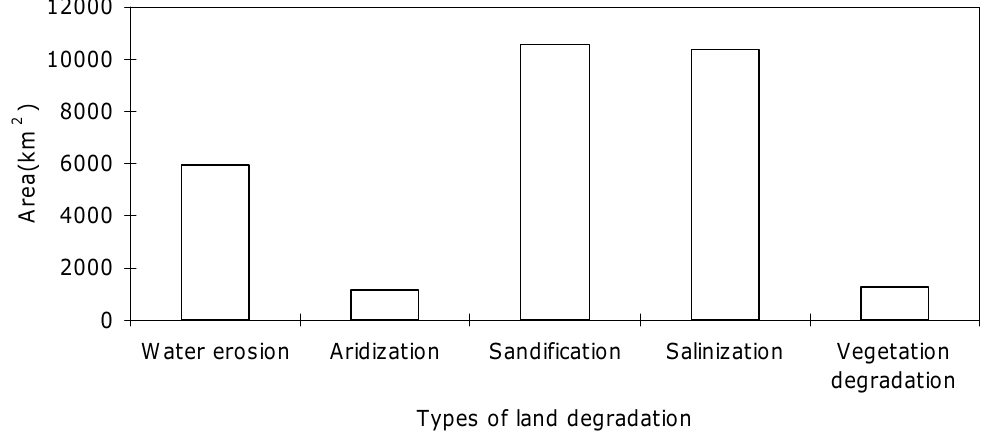
Figure 3. Area of different types of degraded land in the Heihe River